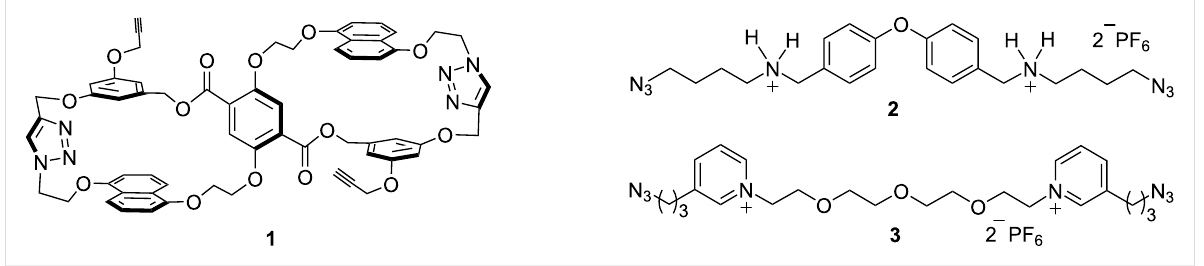
Figure 1: Structures of electron-rich bis-macrocyclic host 1 , and electron-poor guests bis(ammonium) 2 , and bis(pyridinium) 3 .